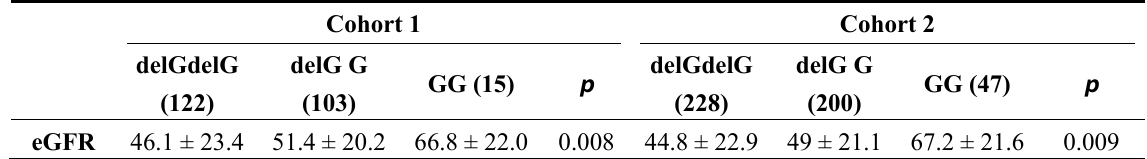
Table 2. The estimated Glomerular Filtration Rate (eGFR) values of study subjects according to Osteopontin ( OPN ) (delG-156G)